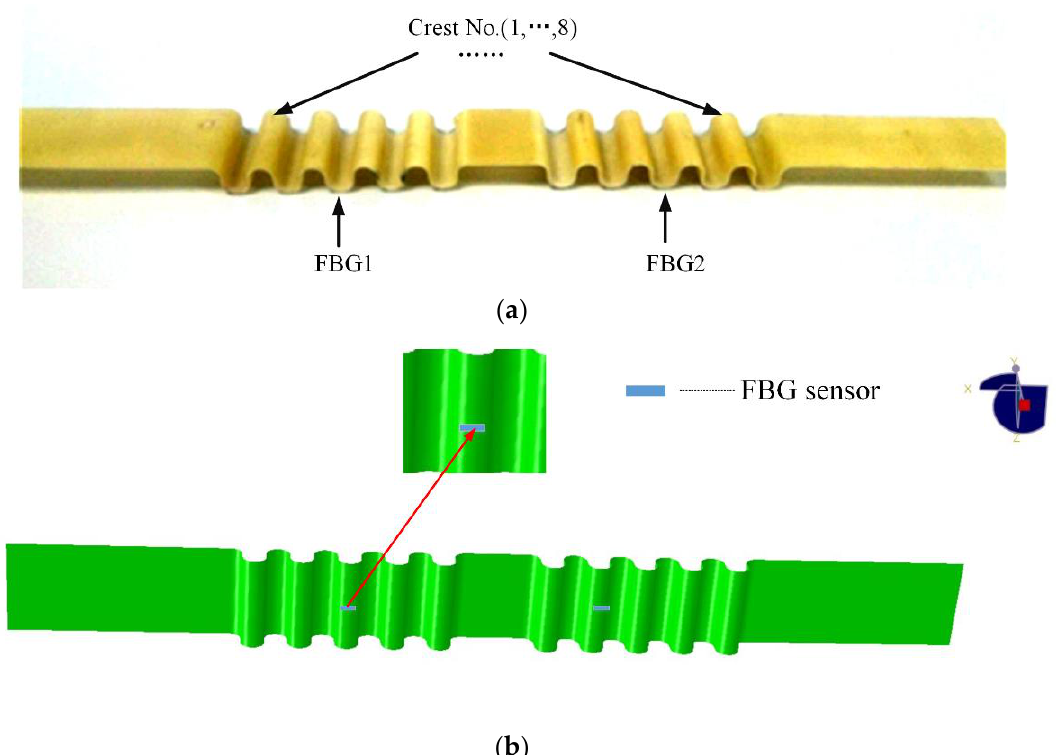
Figure 1. Corrugated composite material skin specimen: ( a ) the crests of the specimen; ( b ) the position of the pasted sen- sors.